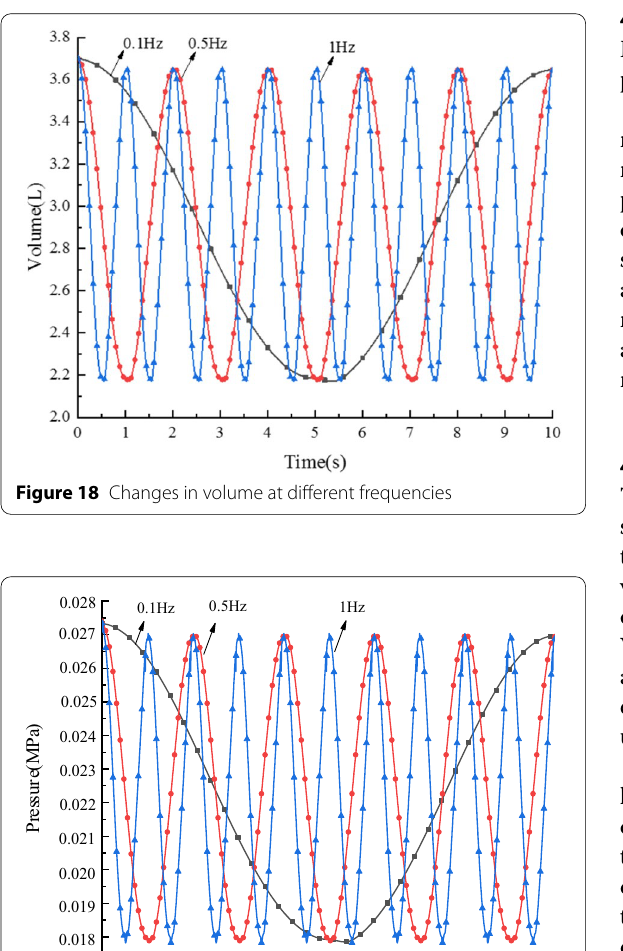
closed-circuit hydraulic system by the on/off of the shut- off valve (2.2) and union tee (3). Before the VVPR worked normally, it needed to replenish oil by opening 2.2 and 2.3 in retraction to discharge the internal air and set an initial volume (3.7 L in this study) by the open-circuit hydraulic system. The VVPR can then work normally to compensate for the volume difference of the cylinder in the closed-circuit hydraulic system. The parameters of the test rig and main parameters between the conventional open reservoir and designed closed reservoir are presented in Table 5. In this study, volume and mass were dramatically reduced by approxi- mately 98% and 94%, respectively.